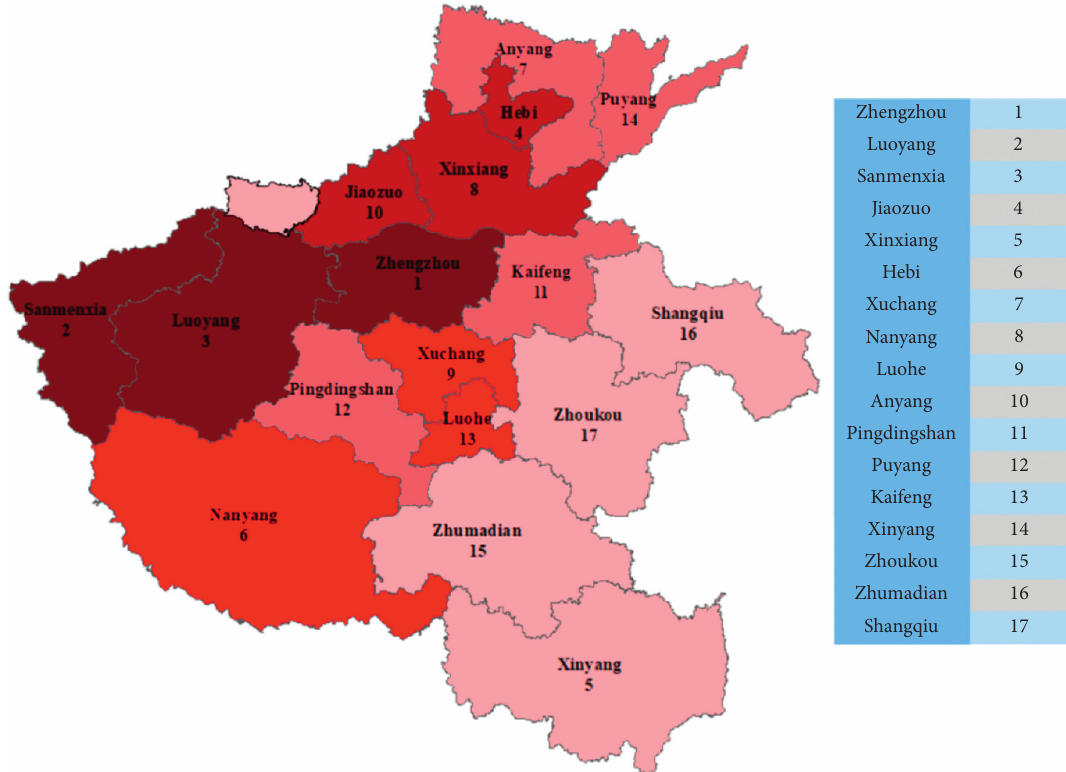
Figure 6: A comprehensive ranking of the sustainable development of cities in Henan Province in the economic